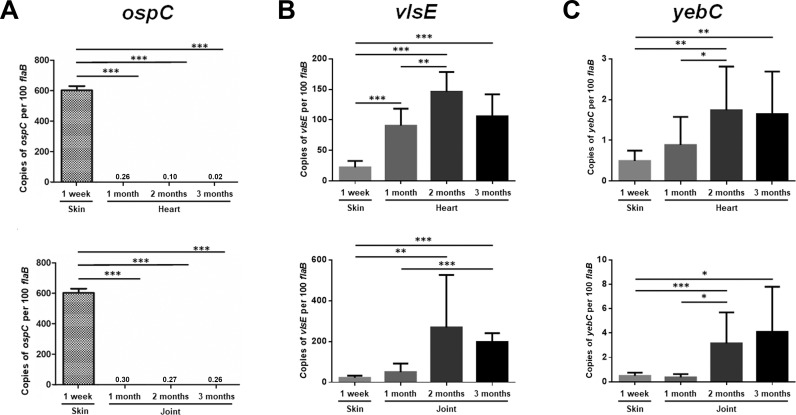
Analyses of yebC, vlsE and ospC expression in mouse tissues by qRT-PCR.Groups of C3H/HeN mice (n = 3 for each data point) were inoculated with 106 of wild-type spirochetes (5A4NP1) via the intradermal dorsal route. Mice were euthanized at 1-week, and 1, 2, 3 months post infection and skin (site of infection), heart (top) and joint (bottom) tissues were collected and then were subjected to RNA extraction followed by qRT-PCR analyses. The ospC (A), vlsE (B), and yebC (C) transcripts were analyzed in mouse samples by qRT-PCR via absolute quantification. The values represent the average copy number of ospC, vlsE or yebC normalized relative to 100 copies of flaB. All data are collected from three independent experiments, and the bars represent the mean values, and the error bars represent the standard deviation. *, p < 0.05; **, p < 0.01; ***, p < 0.001.